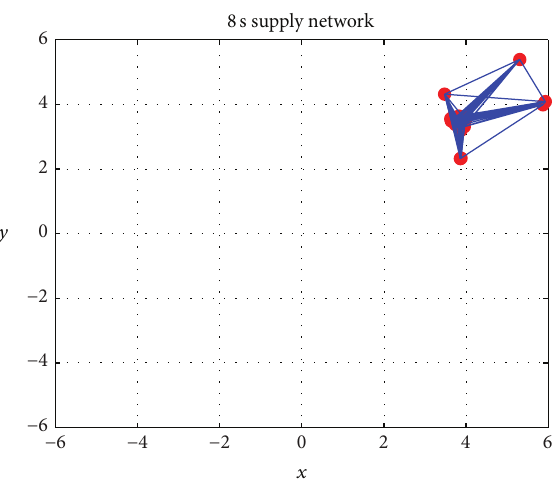
Figure 9: The emergence of connectivity and rate of information